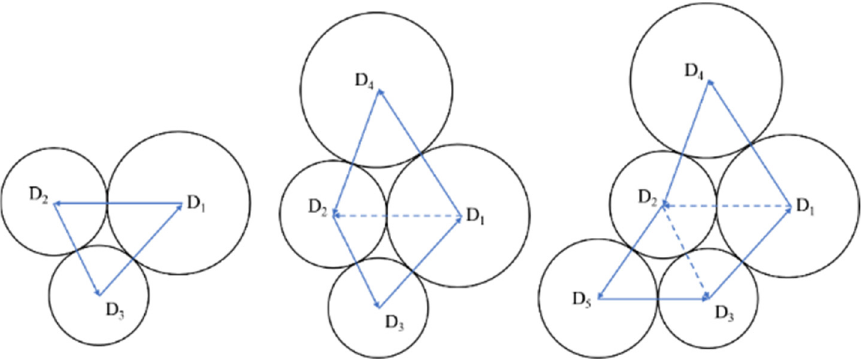
Figure 3. Schematic of the idea of the advancing front method [22].